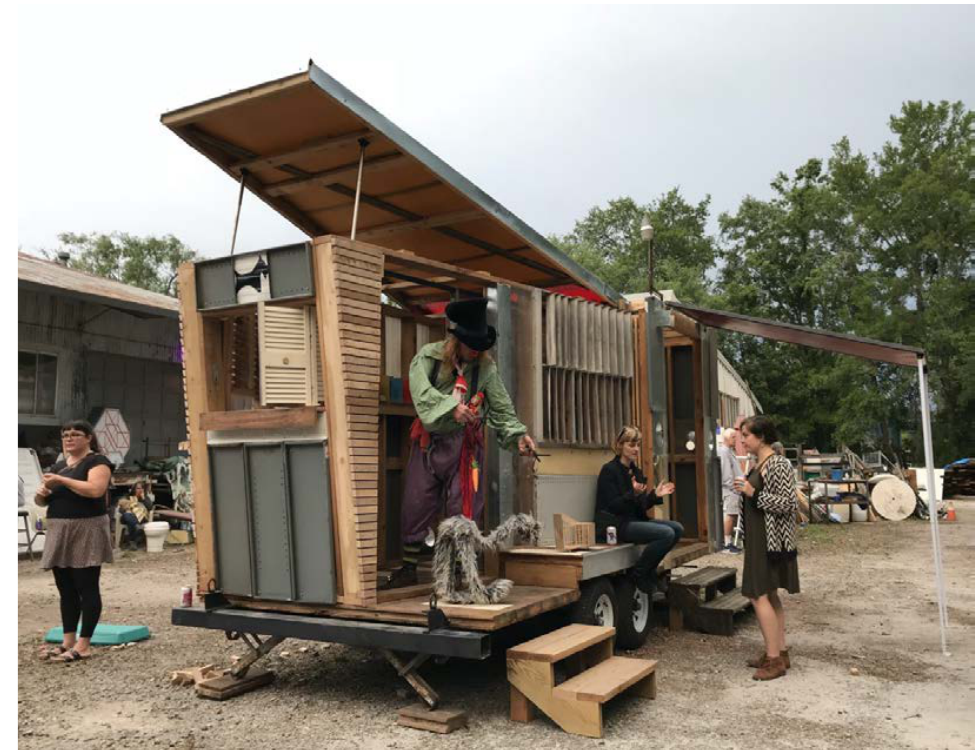
Figure 14. The Maker-Space Trailer at The Repurpose Project, 2018.